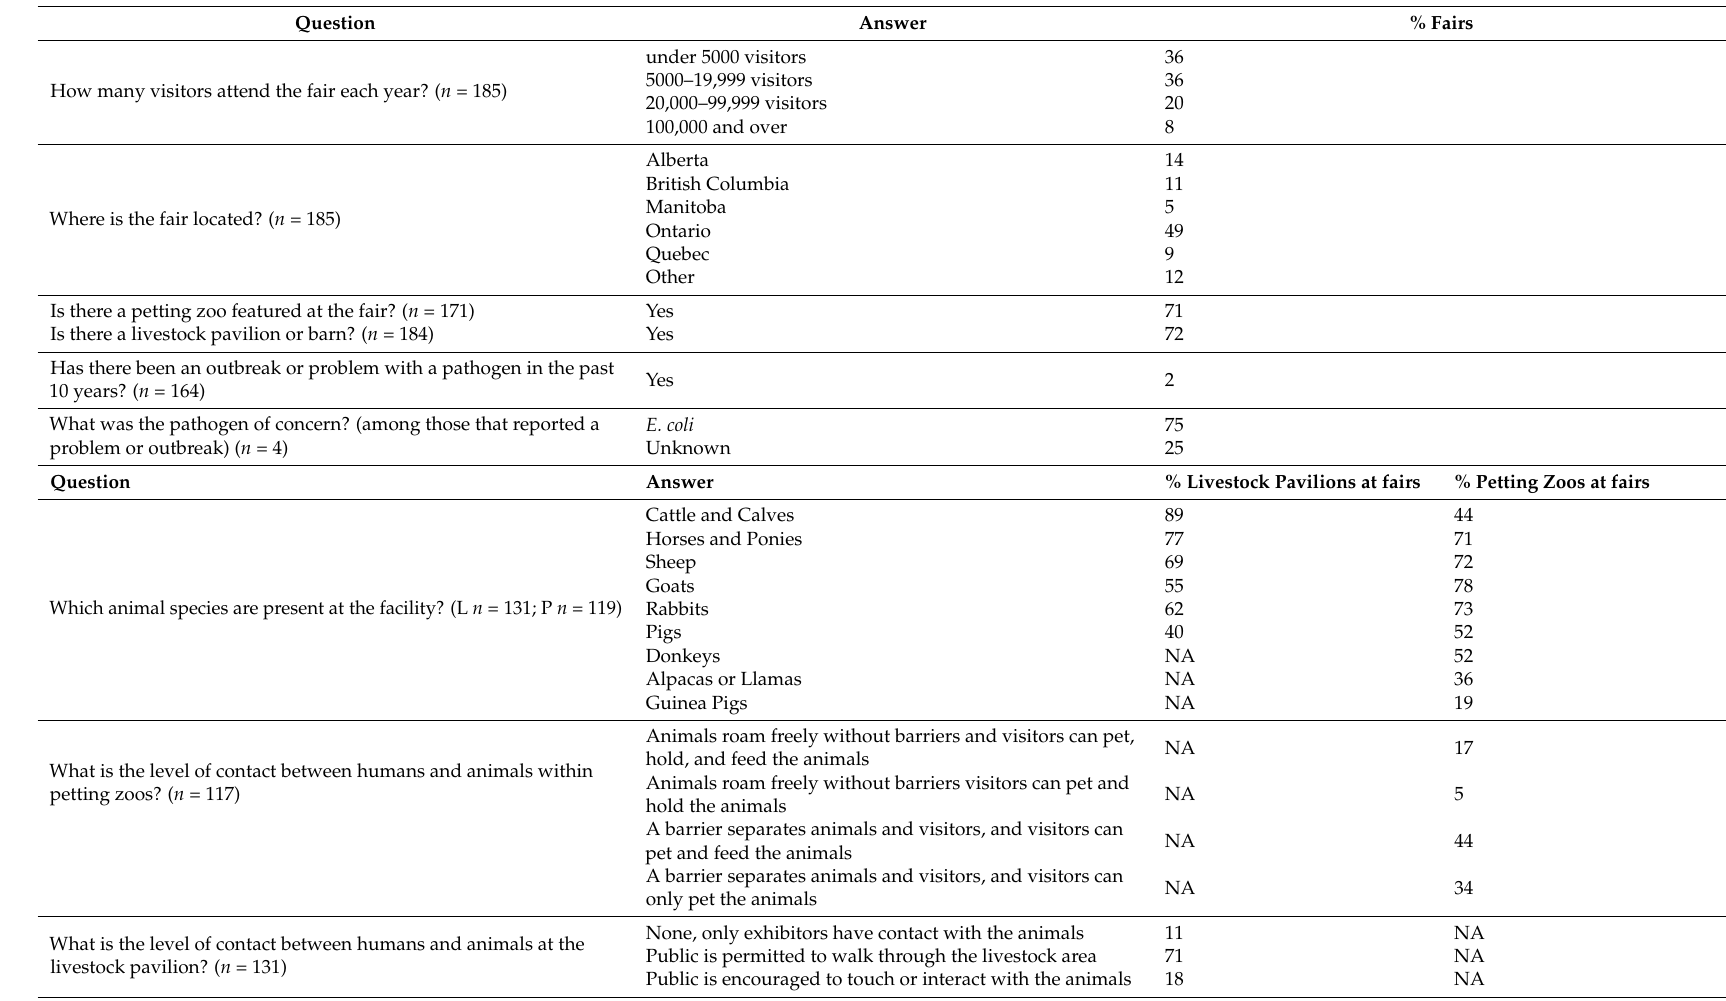
Table 1. Summary of the survey results concerning livestock pavilions and petting zoos at fairs across